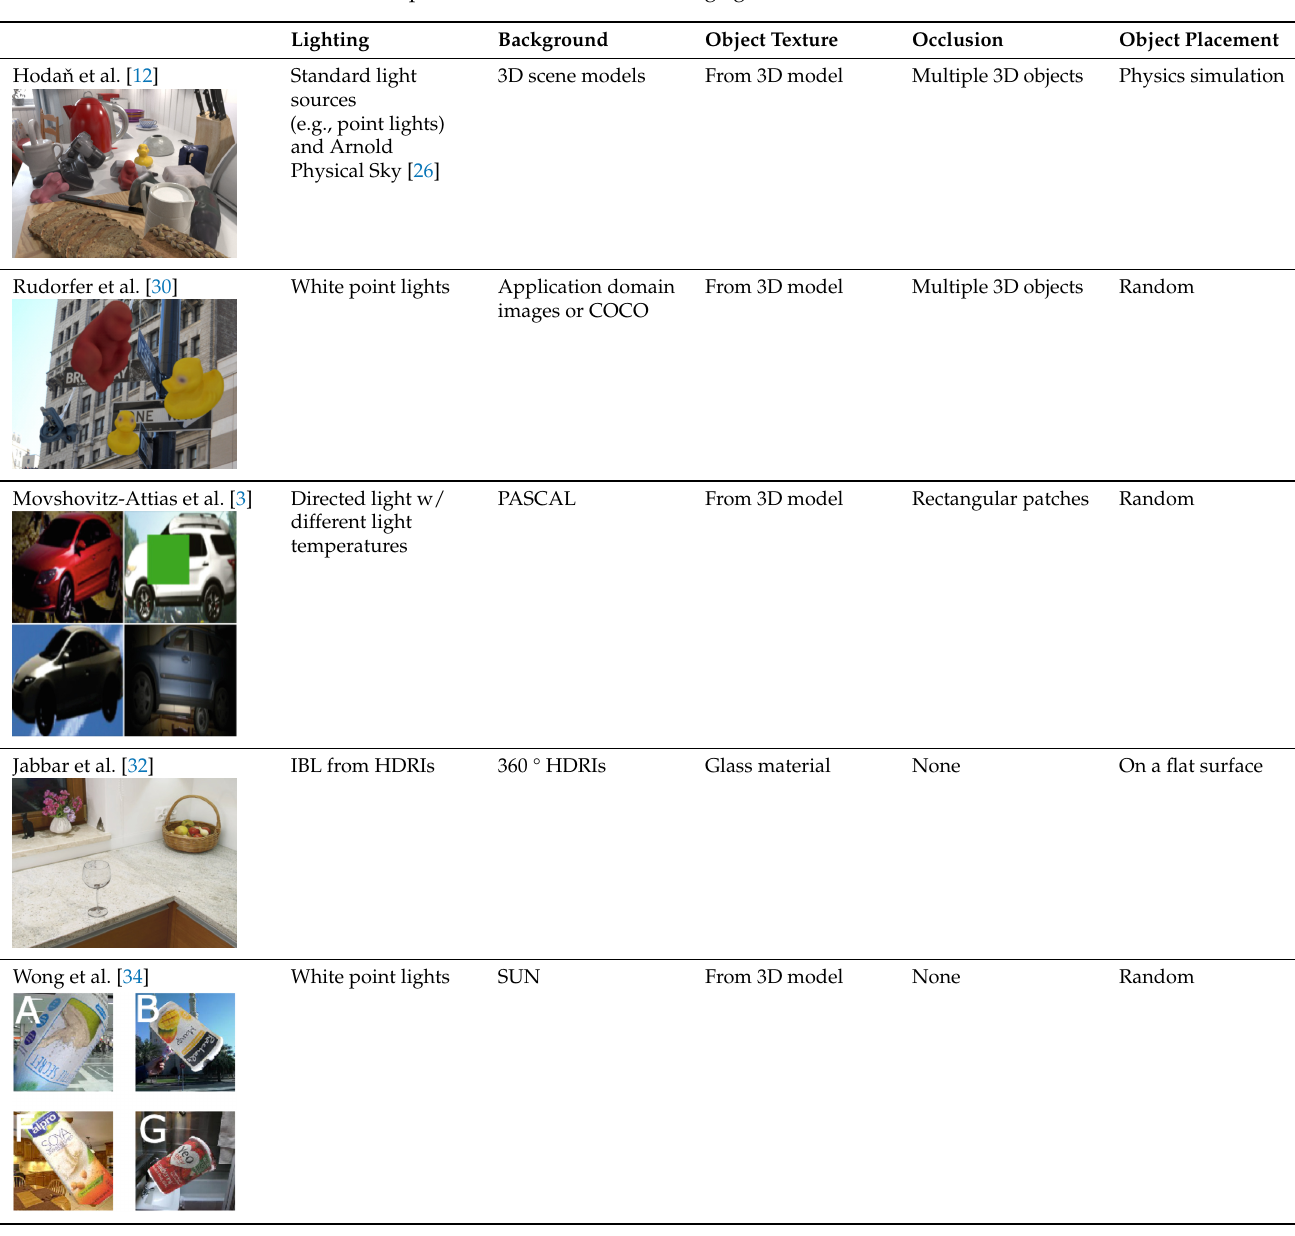
Table 1. Comparison of state-of-the-art image generation with PBR and